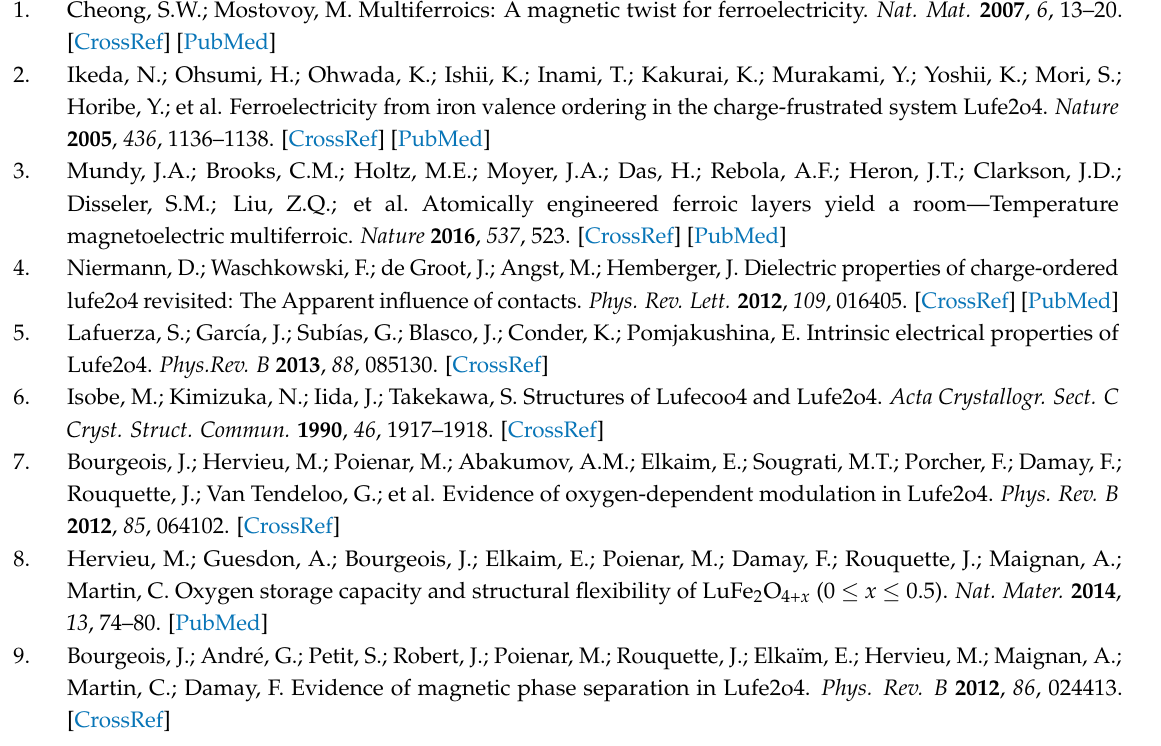
synchrotron X-ray study are also ray study are also shown.